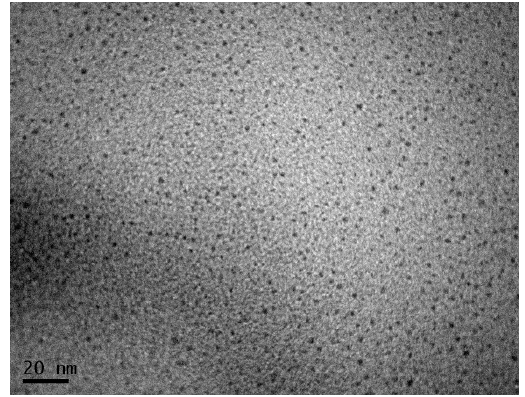
Figure 2. TEM image of CD CA-TETA .